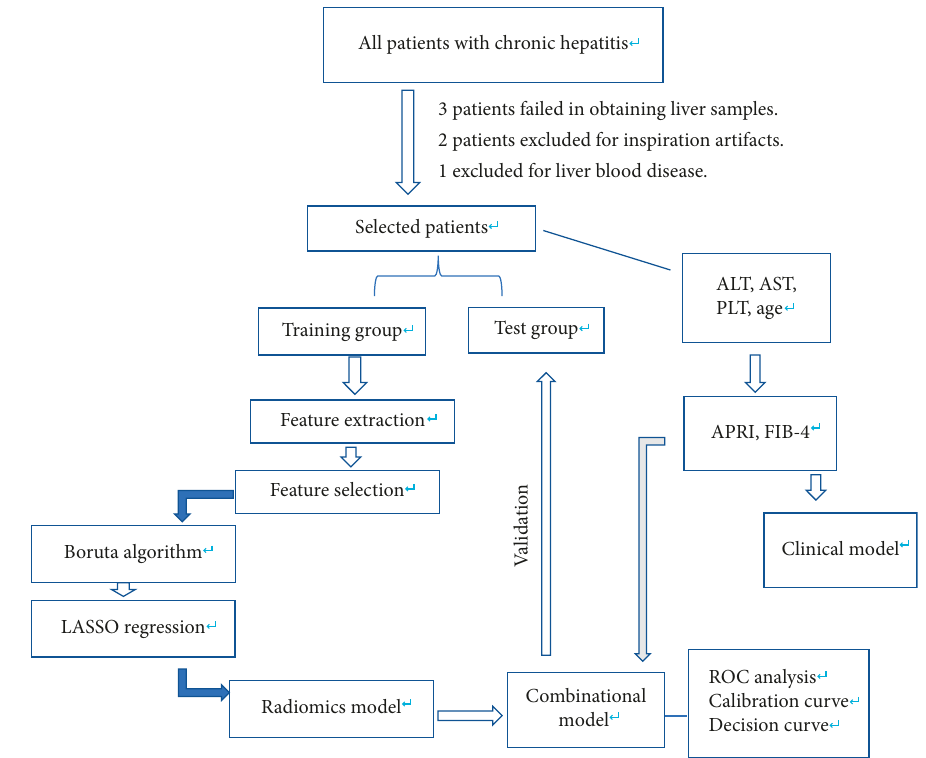
Figure 1: Flowchart of feature selection, model construction, and